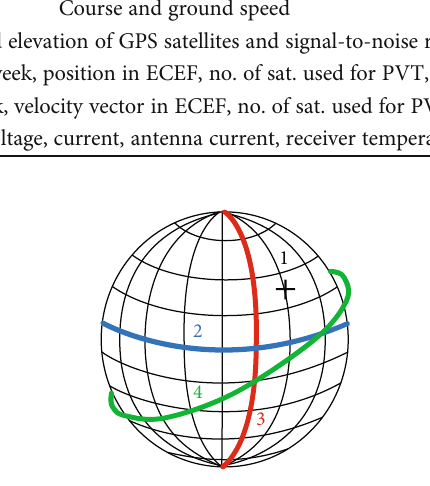
Figure 9: Test scenarios ((1) static, (2) equatorial orbit, (3) prime meridian trajectory, and (4) ISS-like